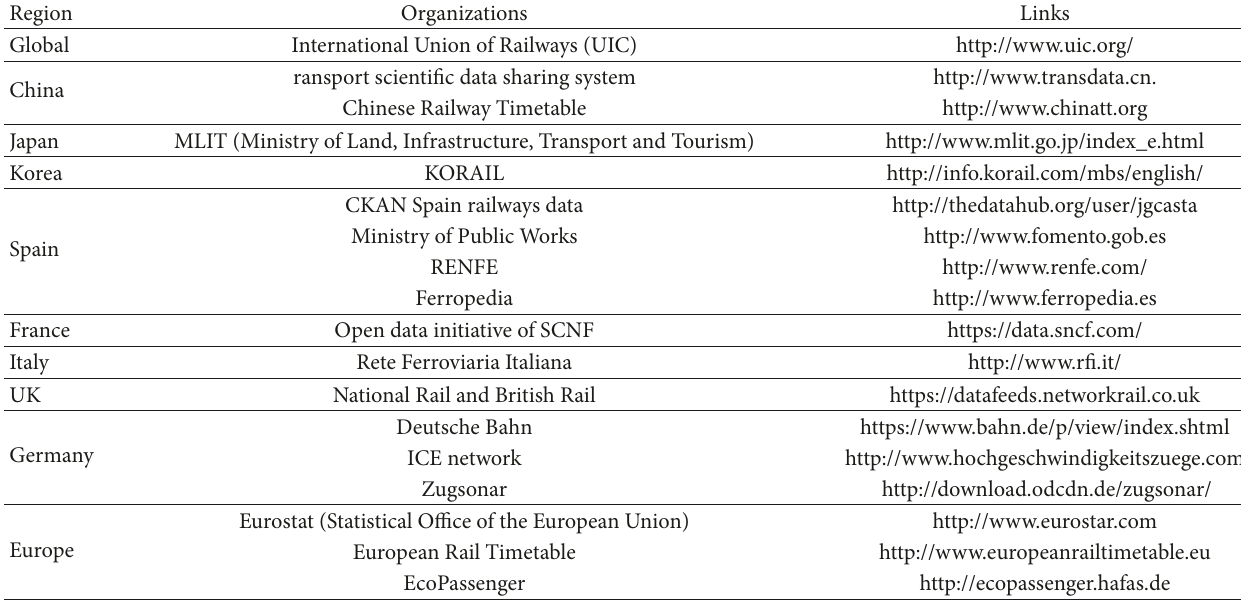
Table 4: An overview of the data sources for high-speed railway.